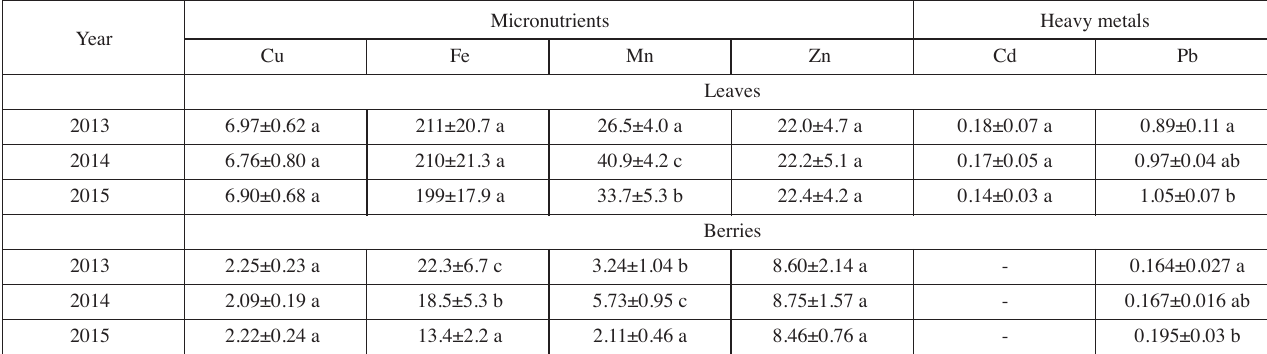
Tab. 3: The average of micronutrient composition and heavy metals (mg/kg) in leaves and berries of ‘Regent’ during three years of study (2013-2015) from the own-rooted and grafted